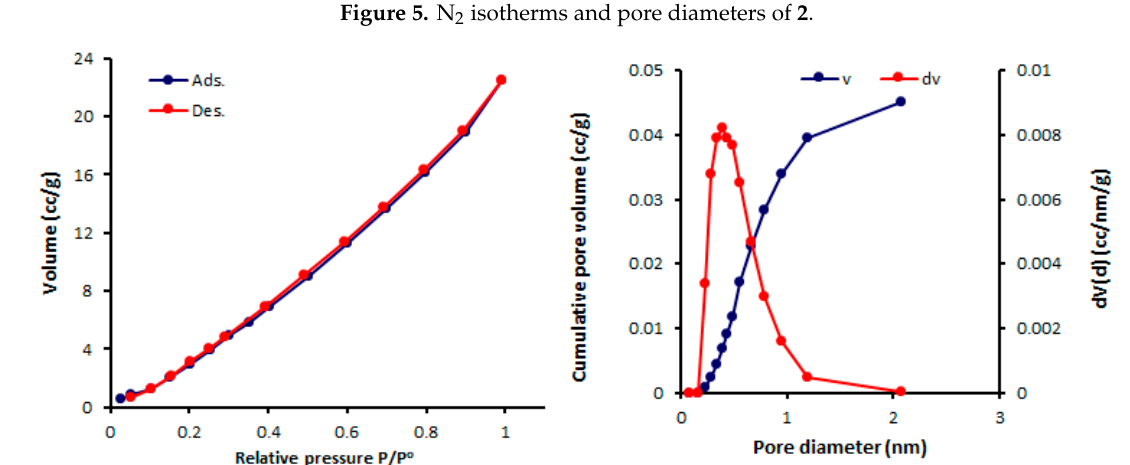
Molecules 2019 , 24 , x FOR PEER REVIEW Figure 5. N 2 isotherms and pore diameters of 2 . Figure 5. N 2 isotherms and pore diameters of 2 .